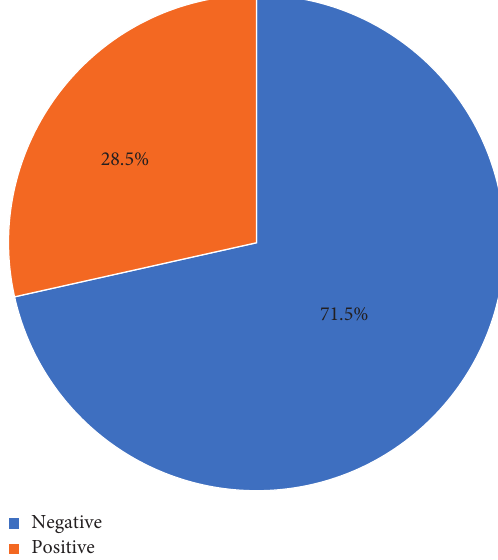
Figure 1: Prevalence of tinnitus among health science students in King Khalid University, Abha, Saudi Arabia,